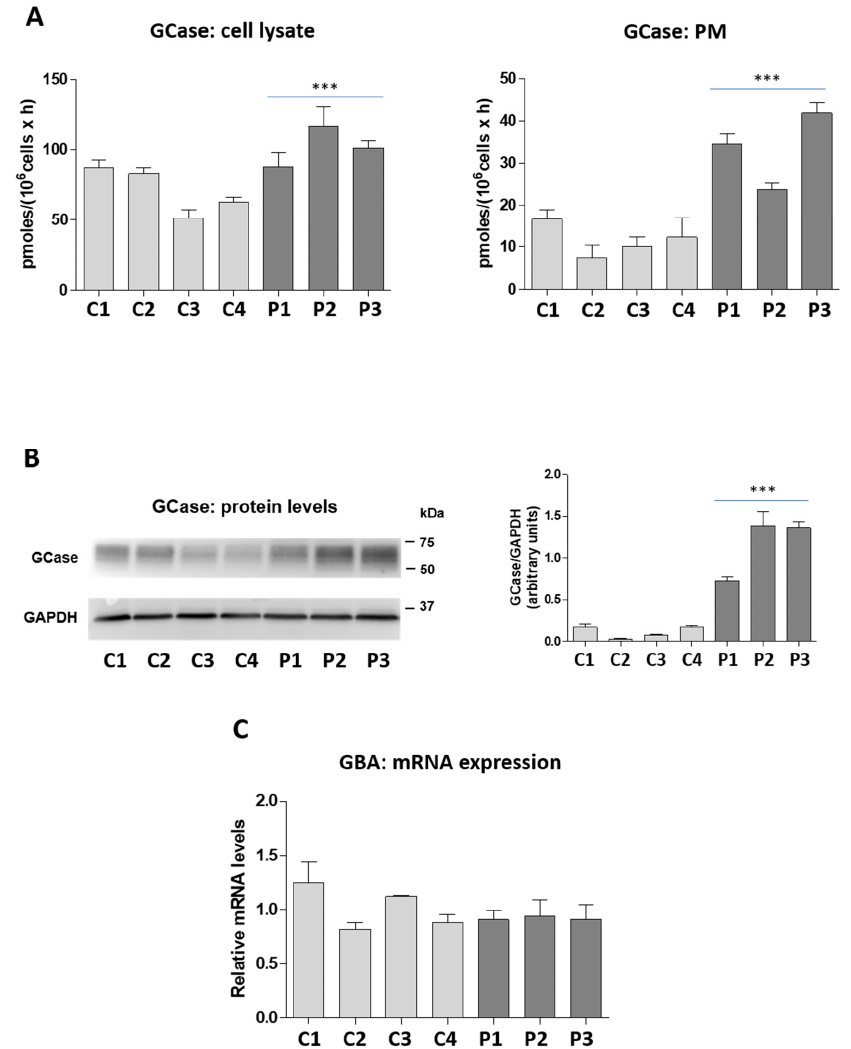
Figure 3. Activity and protein levels of β -glucocerebrosidase (GCase) and GBA mRNA expression. ( A ) GCase activity associated with the total cell lysate and plasma membrane of control (light grey) and patient (dark grey) derived LCLs. Activities were expressed as pmoles/10 6 cells/h. Data are expressed as mean ± SD ( n = 4, *** p < 0.0001 vs. controls). ( B ) Immunoblot of GCase and control GAPDH accompanied by the semi-quantitative graph of normalized GCase/GAPDH. Data are expressed as mean ± SD ( n = 4 *** p < 0.0001 vs. controls). ( C ) The graph represents the GBA mRNA levels of controls (light grey) and patients (dark grey) relative to the average value of controls ( n = 4), after normalization with the endogenous β -actin gene ( ACTB ). Values represent the mean ± SEM of two independent triplicate